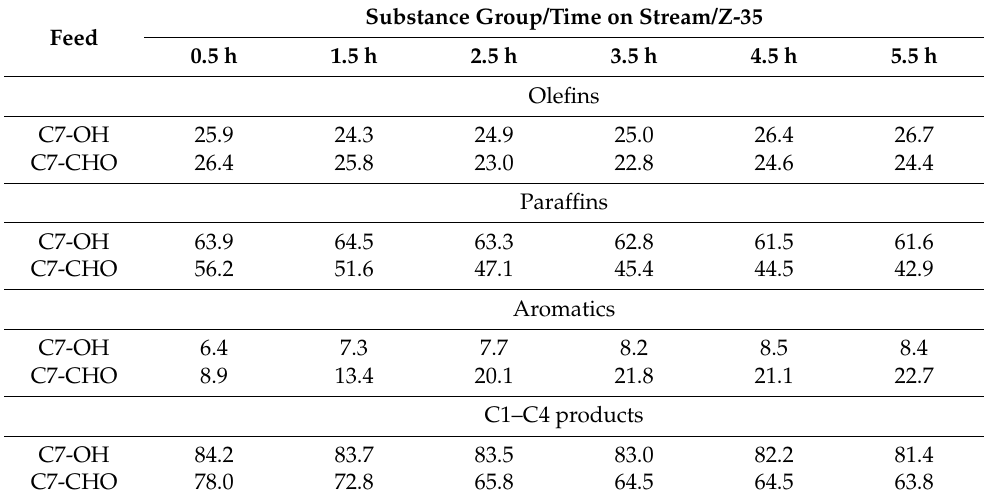
Table 3. Comparison of catalytic data of prepared H-ZSM-5 samples during the conversion of different feeds based on substance group (carbon yield) with dependence on Time on